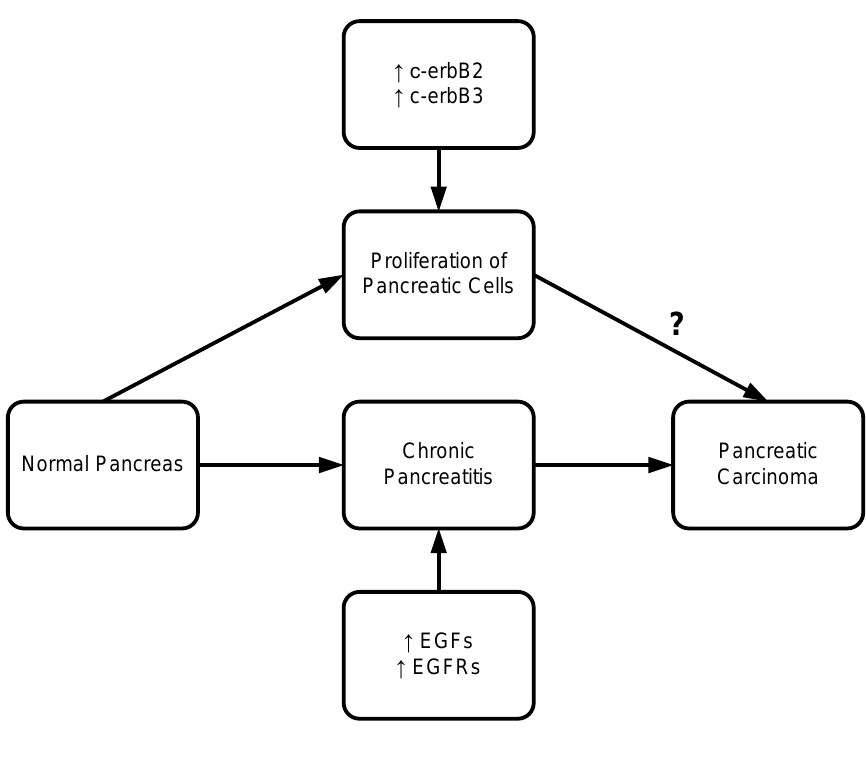
Figure 7. Role of EGF and EGFRs family members in pancreatic